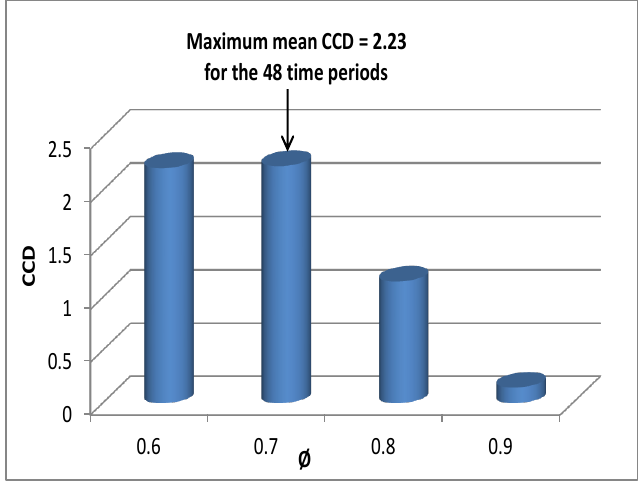
Figure 9. The mean values of connected clusters’ dissimilarity versus the weight coefficient φ